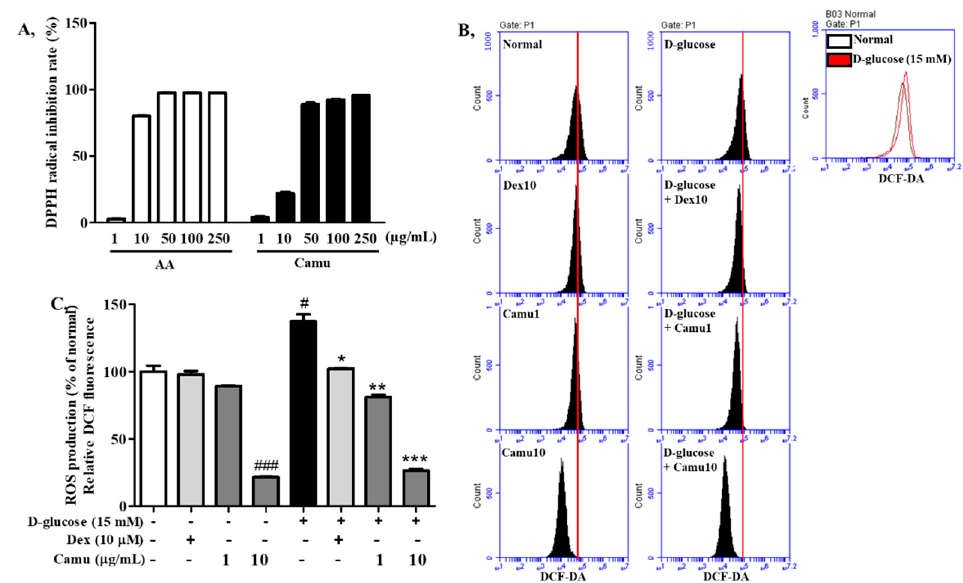
Figure 2. Antioxidative activities of the camu ‐ camu fruit extract. DPPH radical ‐ scavenging activity of the camu ‐ camu fruit extract ( A ). Levels of ROS production in the HaCaT cells treated with 15 mM D ‐ glucose for 6 h ( B , C ). The cells were stained with DCF ‐ DA for 30 min; then, the number of cells was plotted versus the dichlorofluorescein detected by the FL ‐ 2 channel. All the data are shown as the means ± SD of three independent experiments. # Significant differences between the untreated group and the high glucose ‐ induced group. (# p < 0.05, ### p < 0.001). * Significant differences between the high glucose ‐ induced group and the other groups (* p < 0.05; ** p < 0.01; *** p < 0.001). Dex, dexamethasone.